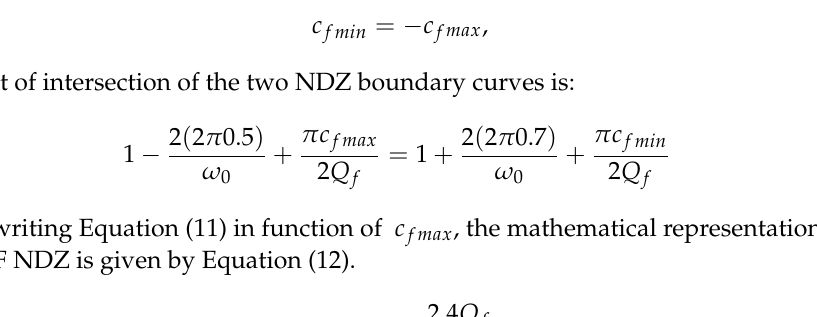
Figure 5. AFDPCF NDZ for c f Differently from the SFS algorithm, a criterion that conditionate the value of AFDPCF parameters to the value of Q f was never proposed. Considering